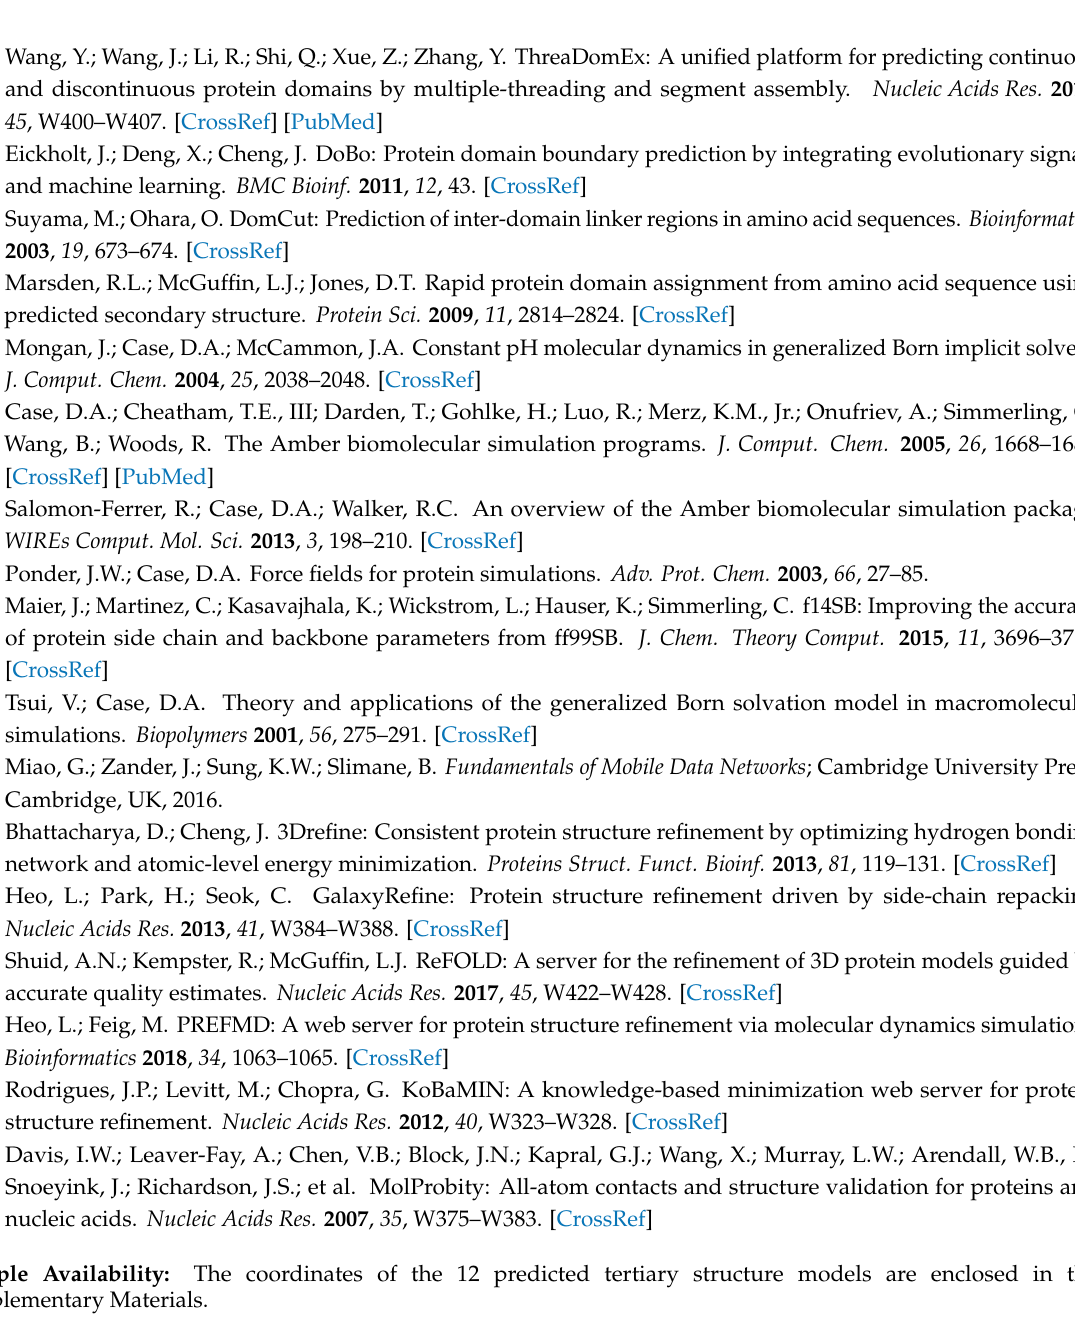
Sample Availability: The coordinates of the 12 predicted tertiary structure models are enclosed in the Supplementary